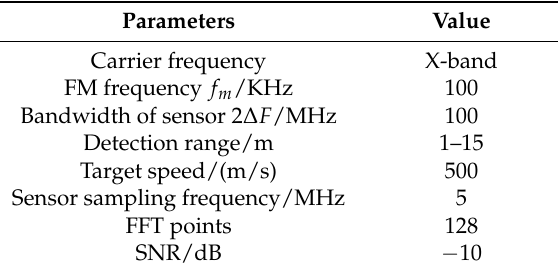
Table 1. Simulation parameters.